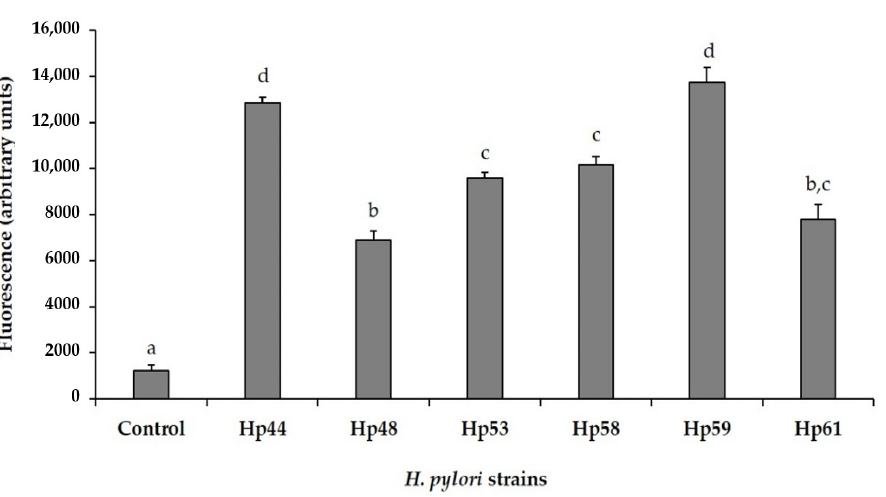
Figure 1. Induction of intracellular reactive oxygen species (ROS) production in human gastric AGS cells after exposure to H. pylori strains. ROS production was determined by fluorescence measurements. a, b, c, d values are expressed as fluorescence emission (mean value ± SD) ( n = 9). Bars with different letters indicate significant differences in ROS production between control group (non-infected AGS cells) and H. pylori -infected cells with the different strains tested (Hp44, Hp48, Hp53, Hp58, Hp59, and Hp61) by ANOVA post hoc LSD Tukey test ( p ≤ 0.05). As shown in Figure 2, in all cases, GSE significantly ( p ≤ 0.05) decreased intracellular ROS production in AGS cells after infection with H. pylori . GSE induced an inhibition of ROS production between 30.1% and 71.0%, depending of the infective H. pylori strain. For most of the H. pylori strains, both fractions of GSE (PPC and OPC) contributed to the antioxidant effect in a similar way to the whole extract (GSE) (Hp53, Hp58, Hp59 and Hp61). For strains Hp44 and Hp48, a significantly greater effect ( p > 0.05) of the PPC fraction was observed.